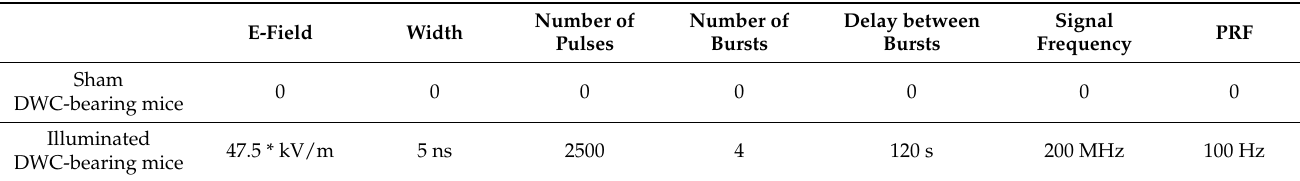
Table 4. Electromagnetic parameters applied in laboratory experiments for wide-band (WB) illuminations of dorsal window chamber (DWC)-bearing